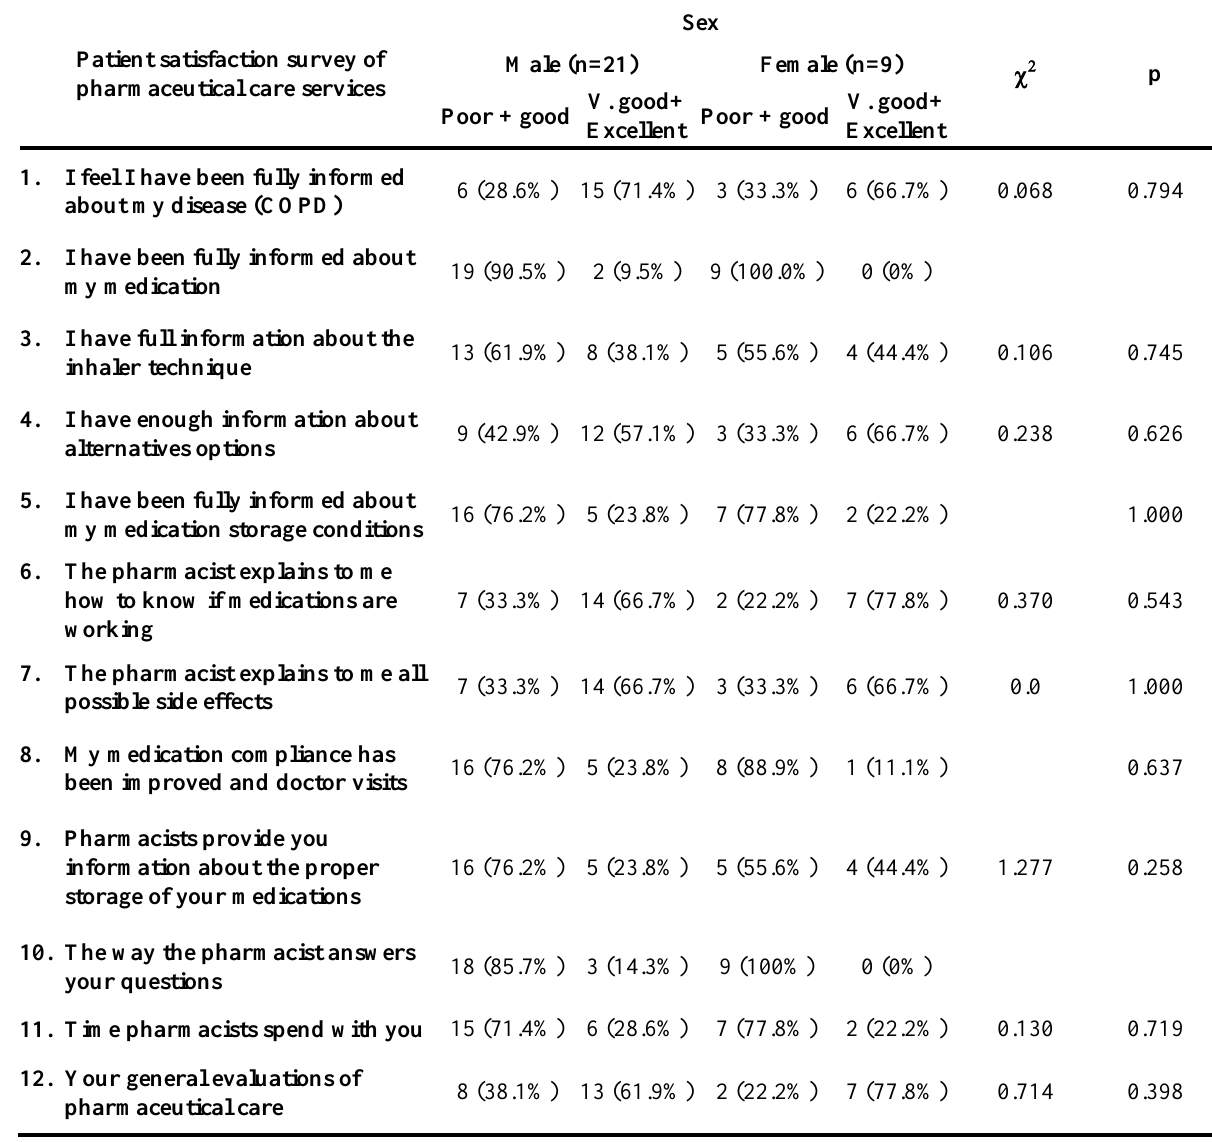
Table 1. Effect of sex on patients' satisfaction towards the provided pharmaceutical care services